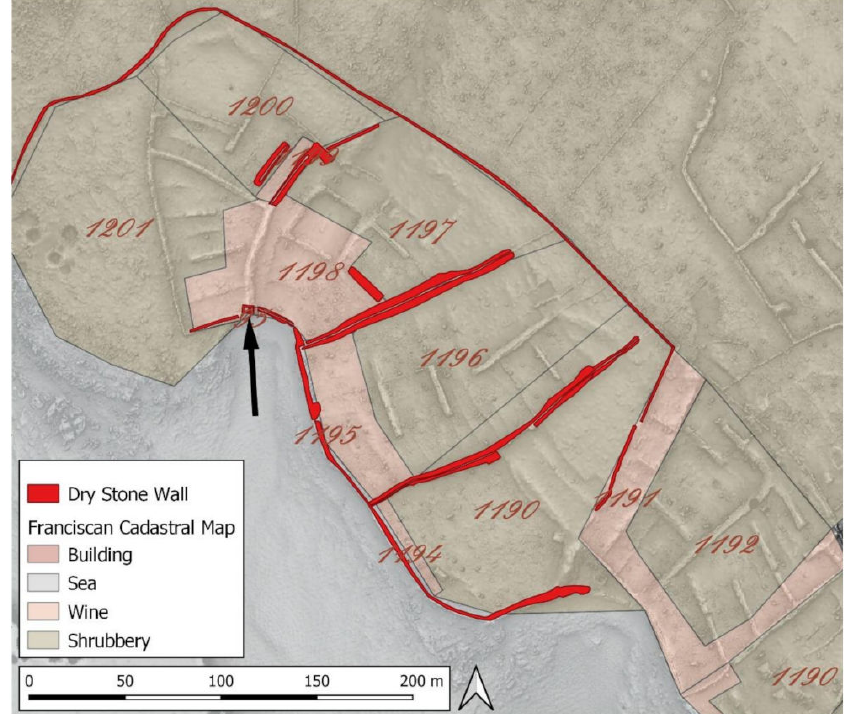
Figure 21. Transcription of the 1821 Franciscan Cadastral Map (source: Archivio di Stato di Trieste— Catasto franceschino/Distretto di Cherso/Comune di Punta Croce/mappa XVI, unit à archivistica 383 b 14) with ALS-based features. The red colour fields indicate the vineyard. The arrow indicates the building shown in Figure 22 (background visualization: cVAT). For explanation, see the